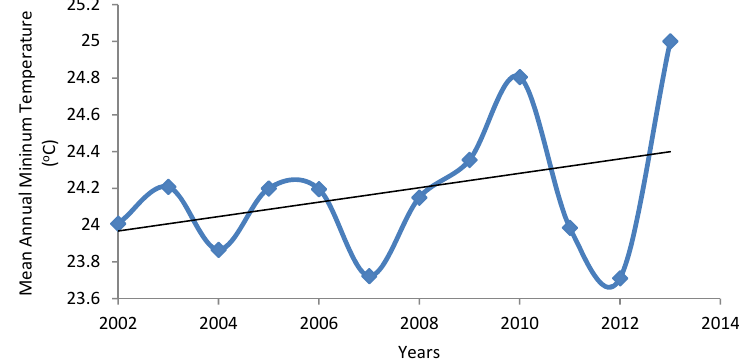
Fig. 7: The trend of the mean annual minimum temperature from 2002 until 2013 for Ikeja, Lagos